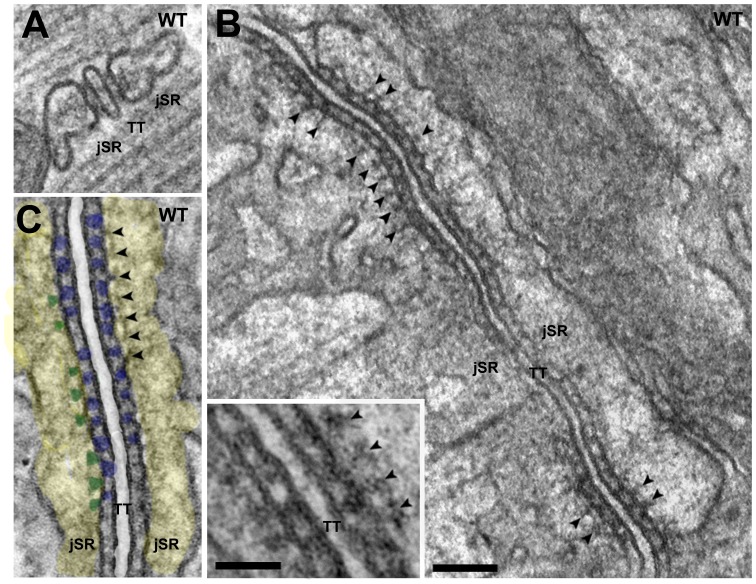
Images from thin sections at right angle to the T-tubule long axis (A) and parallel to it (B, C and inset) from WT EDL muscles.A) In WT muscles the two jSR cisternae (jSR) facing the central T-tubule (TT, white space) are relatively large, they contain electron dense polymer of CASQ and are joined to T-tubules by two feet. B, C and inset). A row of periodically disposed feet (RyRs, blue dots in C) fills the jSR-T tubule junctional gap and the profiles of small anchors (green in C) project into the jSR lumen (yellow in C) in a position alternate to that of feet (arrowheads in C, better seen in the inset). The distal ends of anchor connect to a thin linear density, particularly prominent in C, presumably a long CASQ polymer. Bars: A–C, 0.1 µm; inset, 0.05 µm.